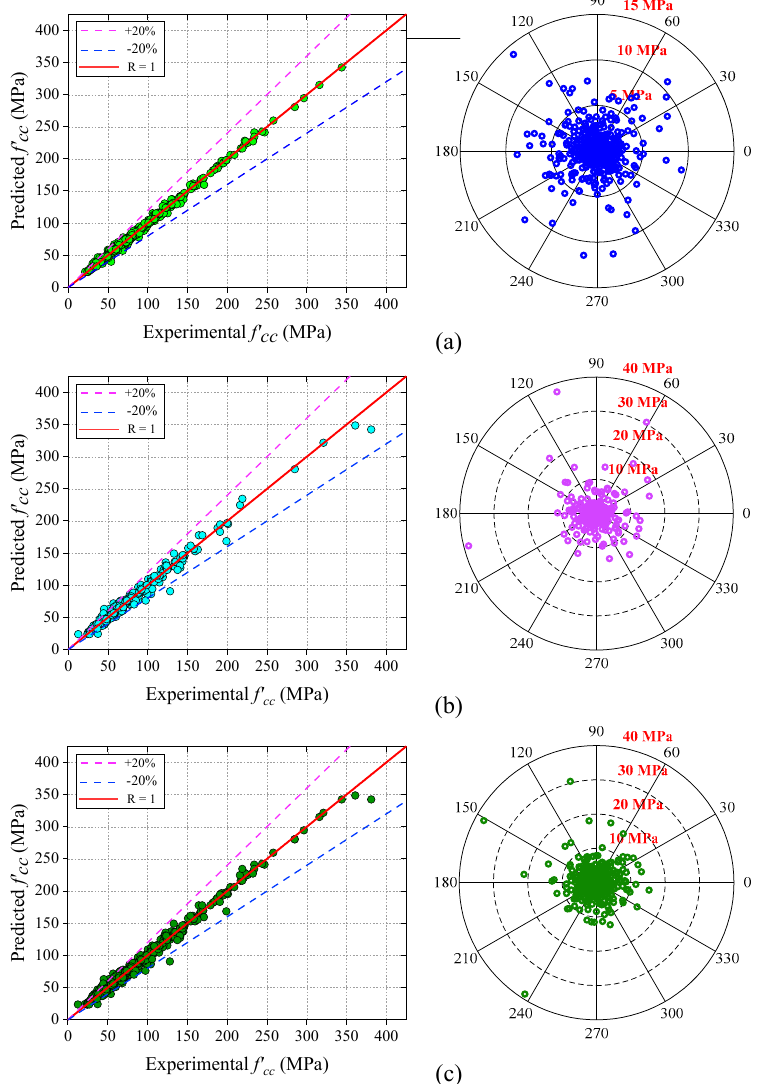
Figure 11. Scatter and absolute error plot of optimized GPR model; ( a ) training, ( b ) testing, and ( c ) whole datasets.